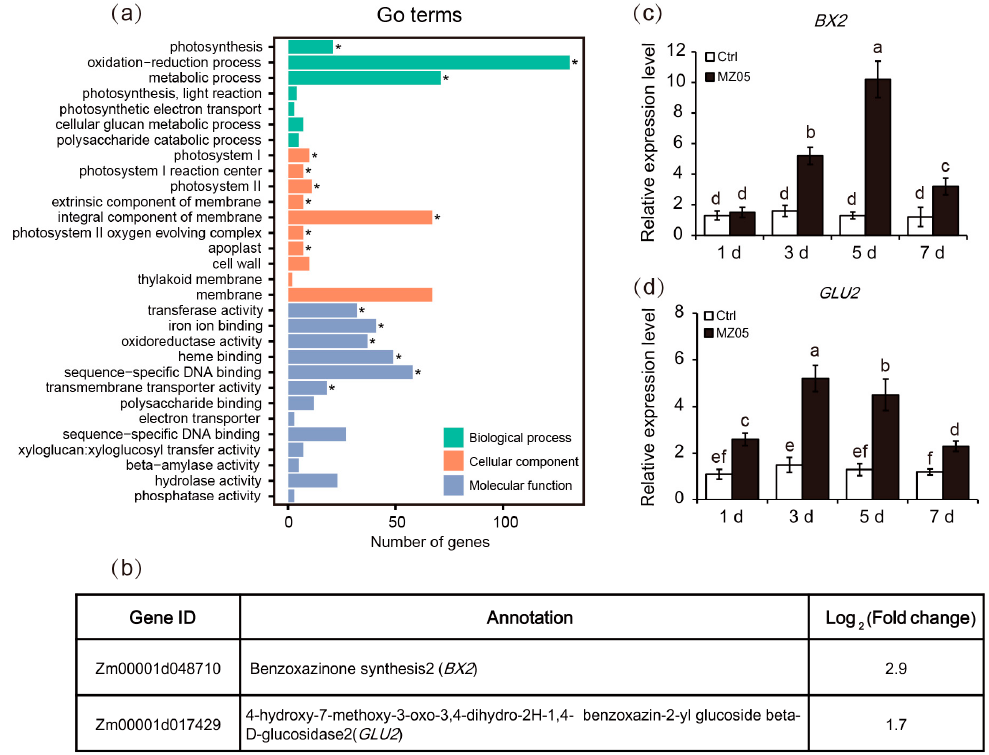
Figure 2. RNA-sequencing analyses of P. fluorescens MZ05-inoculated plants. Four-week-old maize seedlings were treated with or without bacterial suspensions of MZ05 ( 1 × 10 8 CFU/g soil ) for 7 days. Then, the fourth leaves were collected to extract total RNA for RNA-sequencing. ( a ) List of gene ontology (GO) terms for differentially expressed genes (DEGs) based on GO classifications. All of the DEGs were categorized into three groups: Biological process, cellular component, and molecular function. The asterisks indicate the significance of the comparison between the control (Ctrl) and MZ05-inoculated plants. ( b ) Transcription profiles of two BX biosynthetic genes BX2 and GLU2 in the inoculated plants compared with the controls. Moreover, qPCR analyses of the expression of BX2 ( c ) and GLU2 ( d ) in maize plants exposed to di ff erent inoculation times of MZ05. Di ff erent letters indicate statistically significant di ff erences between the control and inoculated plants using one-way analysis of variance and Ducan’s tests ( p < 0.05).